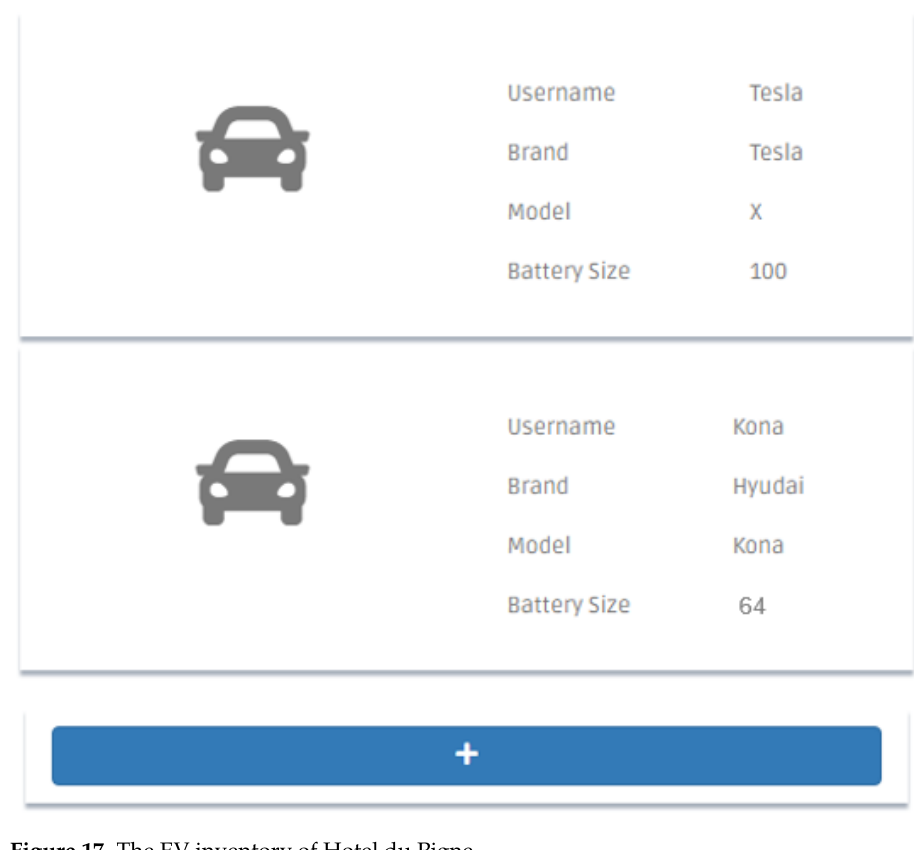
Figure 17. The EV inventory of Hotel du Pigne.